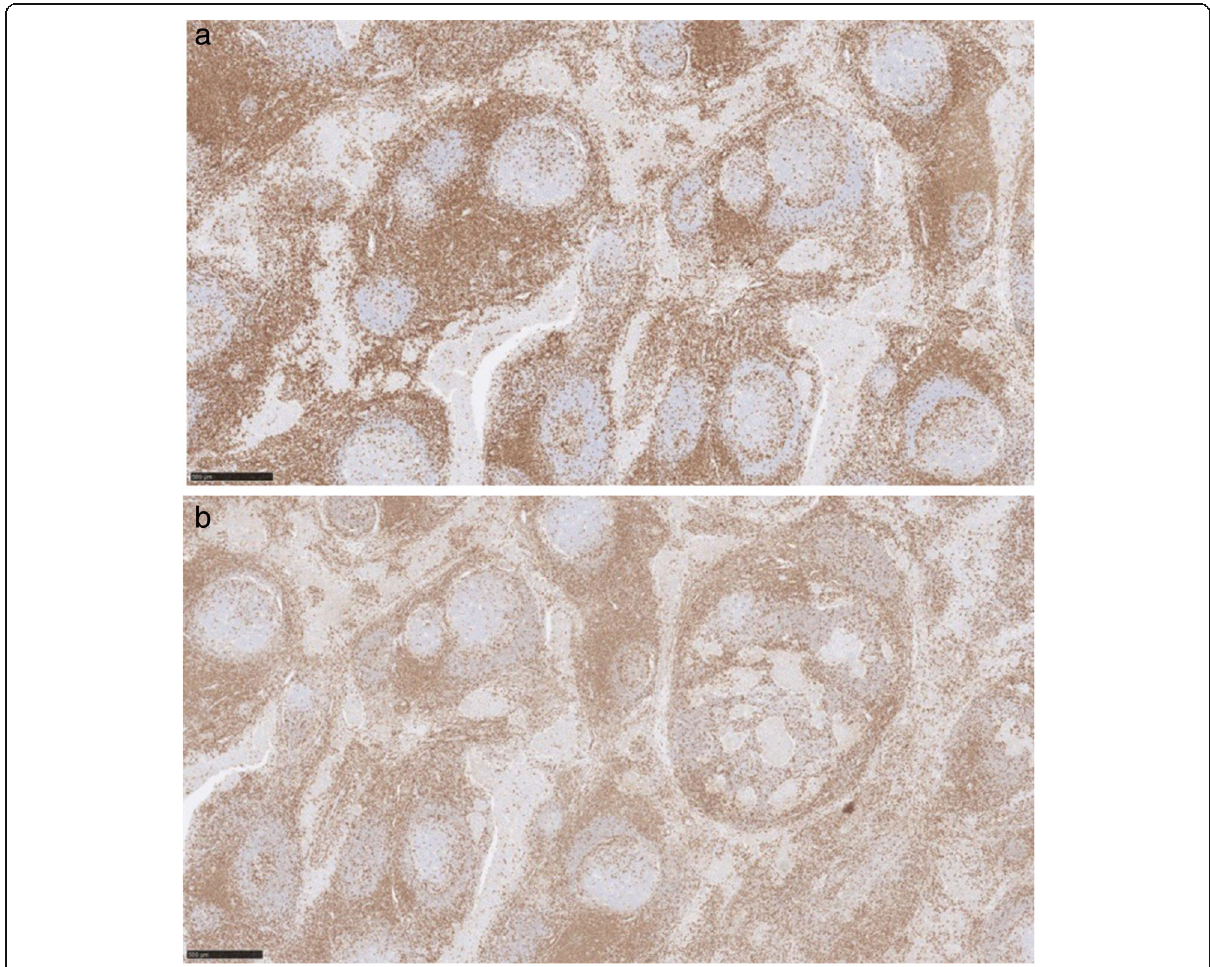
Fig. 7 Immunohistochemistry CD3 (left) CD5 (right), both images × 5 magnification, depict the background T